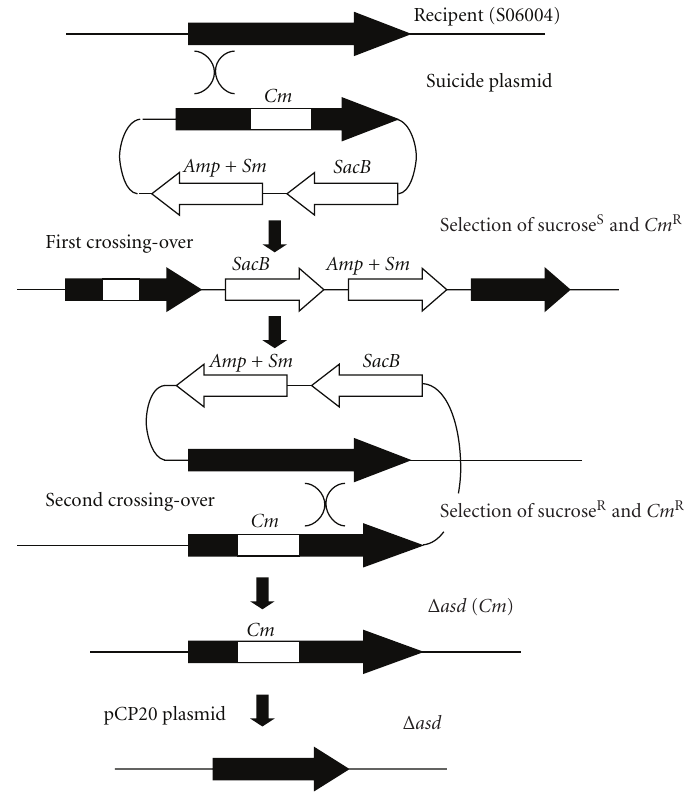
Figure 2: The screening strategy for the SP Δ asd